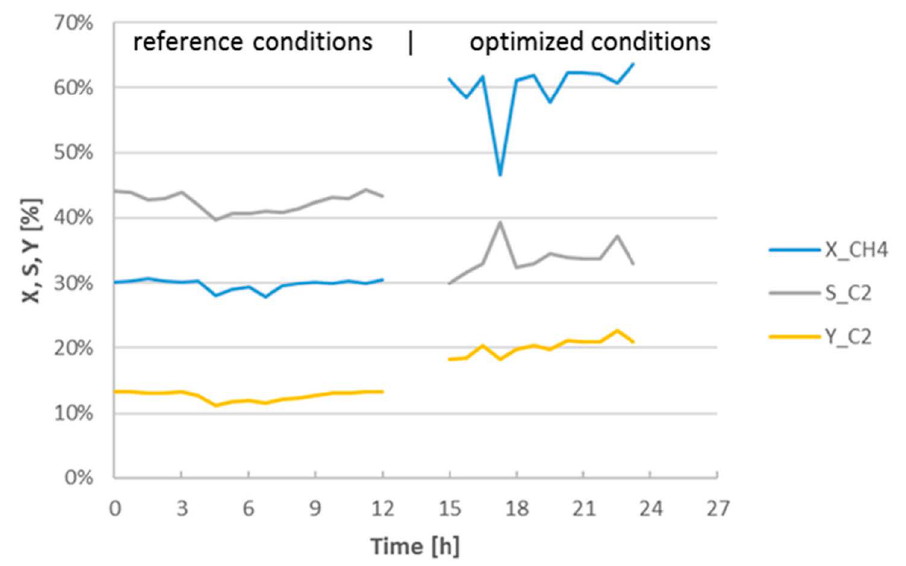
Figure 11. Results from membrane reactor configuration over 12 h on stream and optimized rection conditions for 9 h after 2.5 h catalyst regeneration with pure air; total flow 300 mL/min, 840 ◦ C, GHSV = 2400 mL CH4 g − 1 Cat. h − 1 , CH 4 :O 2 :N 2 :CO 2 = 4:1:5:0 (later